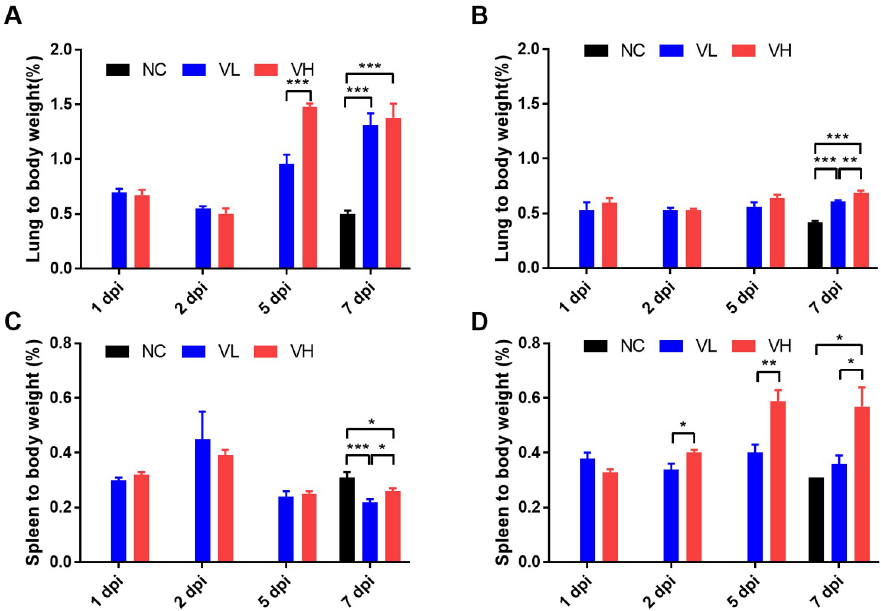
Fig 4. Organ to body weight ratio of SARS-CoV-2 infected K18-hACE2 and CAG-hACE2 transgenic mice. Relative weight of lungs of K18-hACE2 (A) and CAG-hACE2 (B); relative weight of spleens of K18-hACE2 (C) and CAG-hACE2 (D). Data are represented as mean ± SE at indicated day post-infection (dpi). The VH group of K18-hACE2 transgenic mice died at 6 dpi, marked as 7 dpi. � P < 0.05; �� P < 0.01; ��� P < 0.001 as assessed using unpaired two-tailed